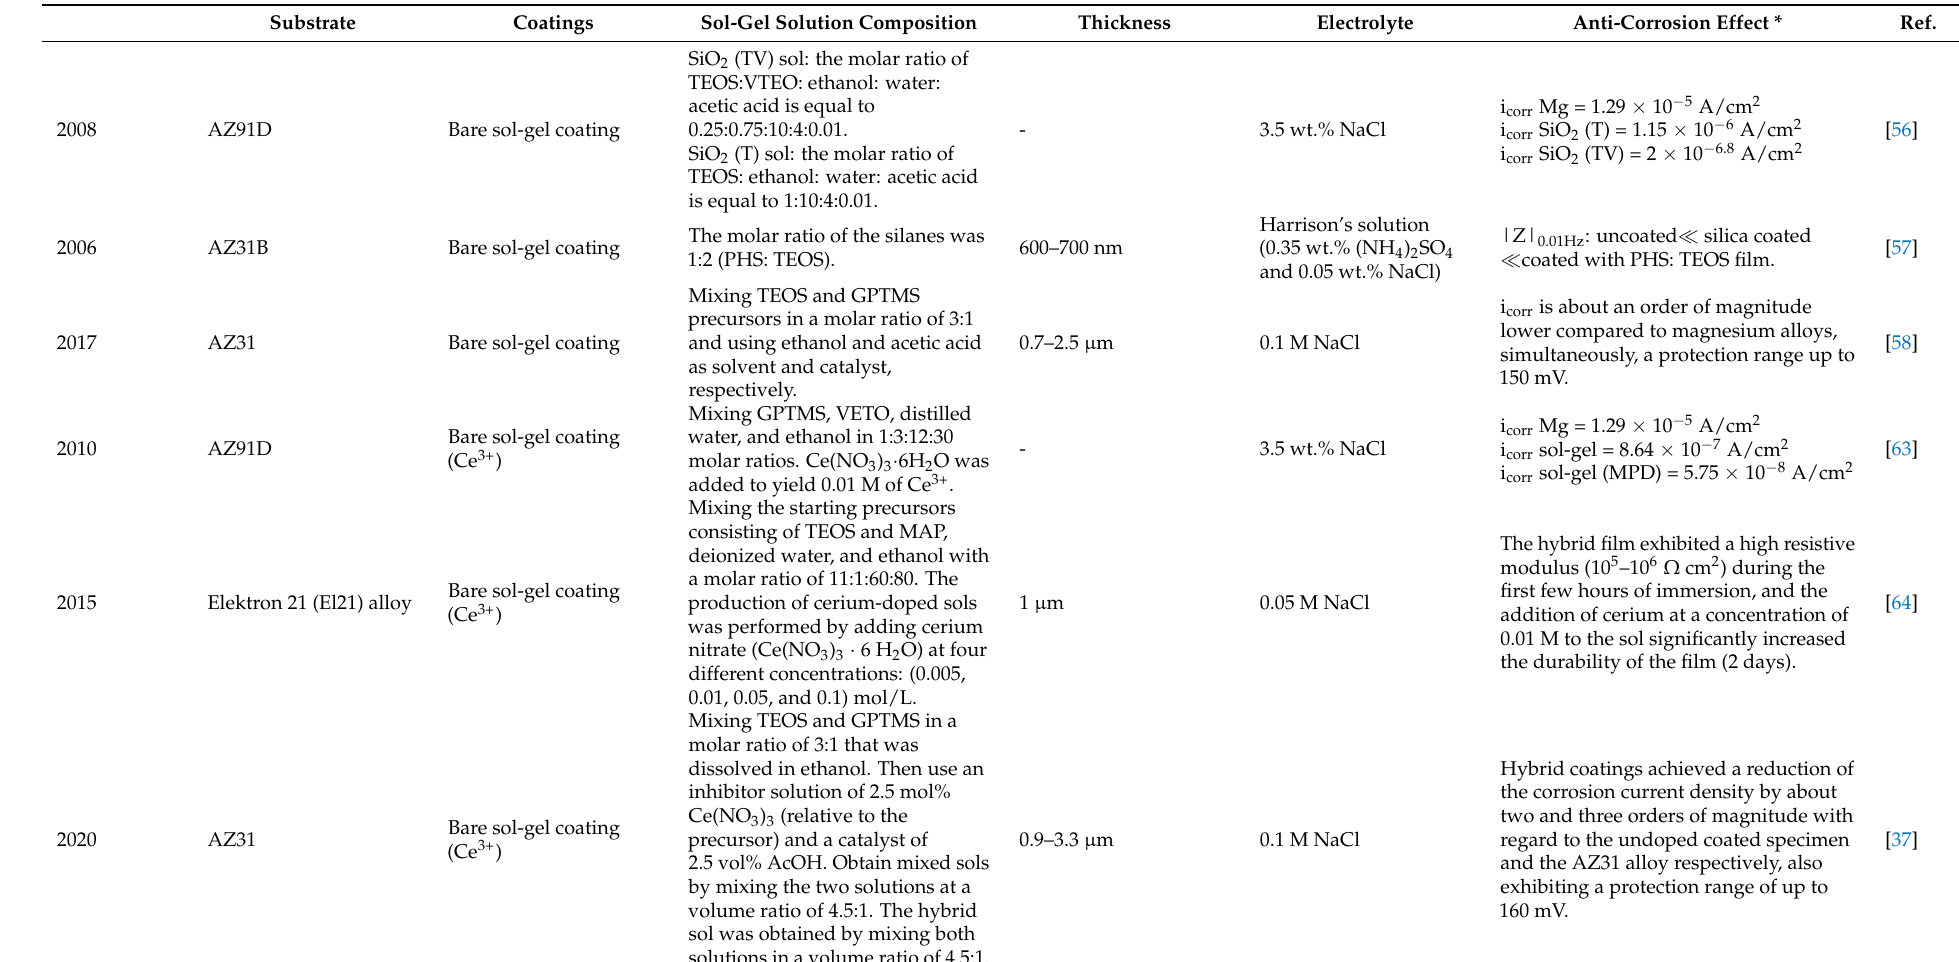
Table 3. Thickness and corrosion resistance of the different sol-gel coatings. Substrate Coatings Sol-Gel Solution Composition Thickness Electrolyte Anti-Corrosion Effect * Ref.